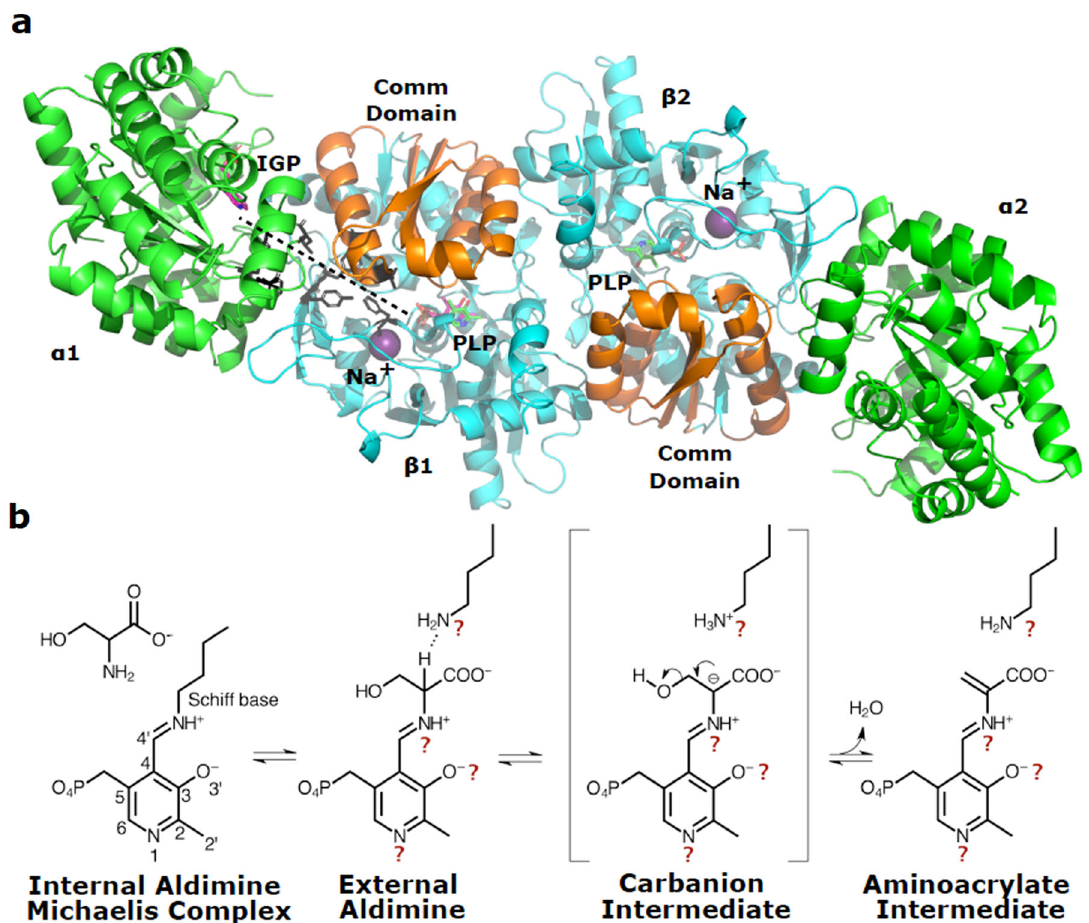
Fig. 1 Salmonella typhimurium tryptophan synthase structure and reaction mechanism. a The TS αββα tetramer ribbon model ( α in green and β in cyan and orange) with indole-3-glycerol (IGP) phosphate bound in the α -active site and pyridoxal 5 ′ -phosphate bound as the internal aldimine in the β -active site (PDB 1BKS and 1QOQ). The cleavage of IGP in the α -reaction releases indole, which travels down a 25 Å hydrophobic channel (dashed line, residues lining the channel shown in black) to the β -active site and couples to a PLP-activated serine (aminoacrylate). The monovalent cation site (occupied by Na + shown as a purple sphere) is involved in coordinating the two reactions. Motion in the communication (Comm) domain (orange) of the β -subunit de fi nes the open and closed conformations of the enzyme. b PLP activation of L-Ser in the TS β -active site initiates with the binding of L-Ser as a Michaelis complex that is likely coupled to the presence of indole in the hydrophobic channel. Numbering of the PLP ring is depicted in the internal aldimine Schiff base structure. The unprotonated α -amino group of L-Ser links to the internal aldimine protonated Schiff base replacing the catalytic lysine (Lys 87) to form the external aldimine. Lys 87 then acts as a general base to abstract a proton from the substrate C α to form the transient carbanionic intermediate, which proceeds through β -elimination to release water and form the reactive aminoacrylate intermediate. Question marks denote atoms where the protonation state is of particular interest. Question marks were omitted from the internal aldimine structure for